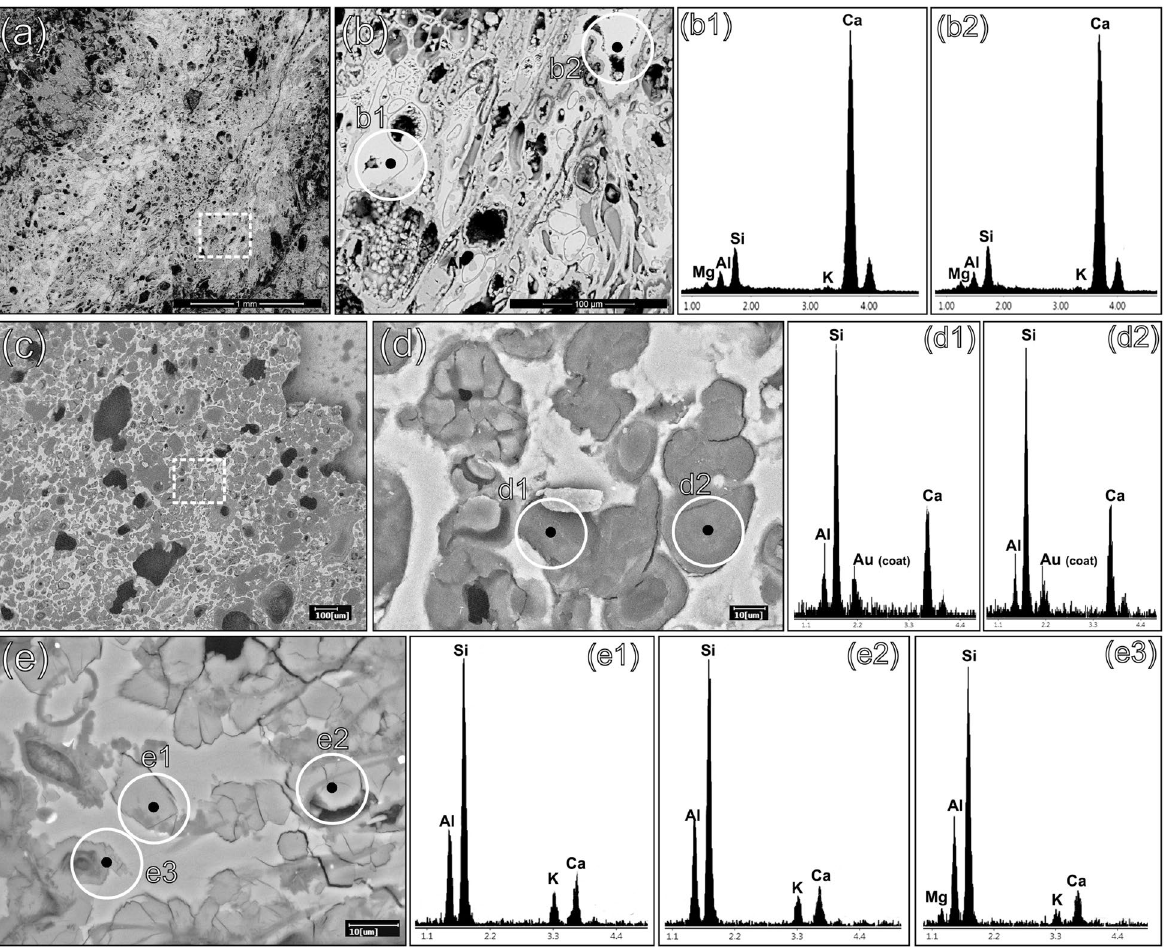
Figure 7. SEM–EDS analyses of reacted pumices in samples PREP_25 and PREP_53. Backscattered electrons (BSE) acquisitions. ( a ) A reacted clast of pumice in sample PREP_25; ( b ) magnification of the dashed area in fig. ( a ); ( b1 , b2 ) EDS spectra of a reacted area of the volcanic glass, with vesicles filled of calcic compounds, likely related to calcium carbonates (calcite or vaterite) from the binder; ( c ) A reacted area of a clast of pumice in sample PREP_53; ( d ) magnification of the dashed area in fig. ( c ); ( d1 , d2 ) EDS spectrum of a C–A–S–H enriched zone, developed from the leached volcanic glass and filling the vesicles; ( e ) zeolitized volcanic glass in a